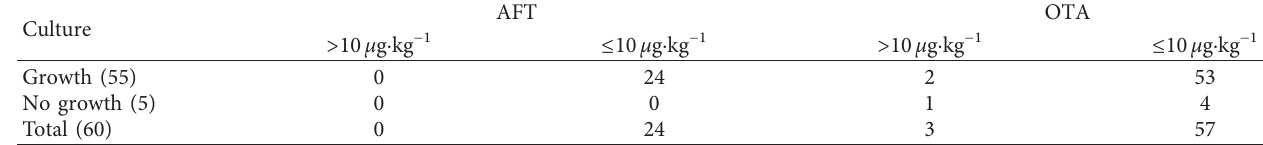
Table 5: The frequency of samples contaminated with mycotoxins based on culture